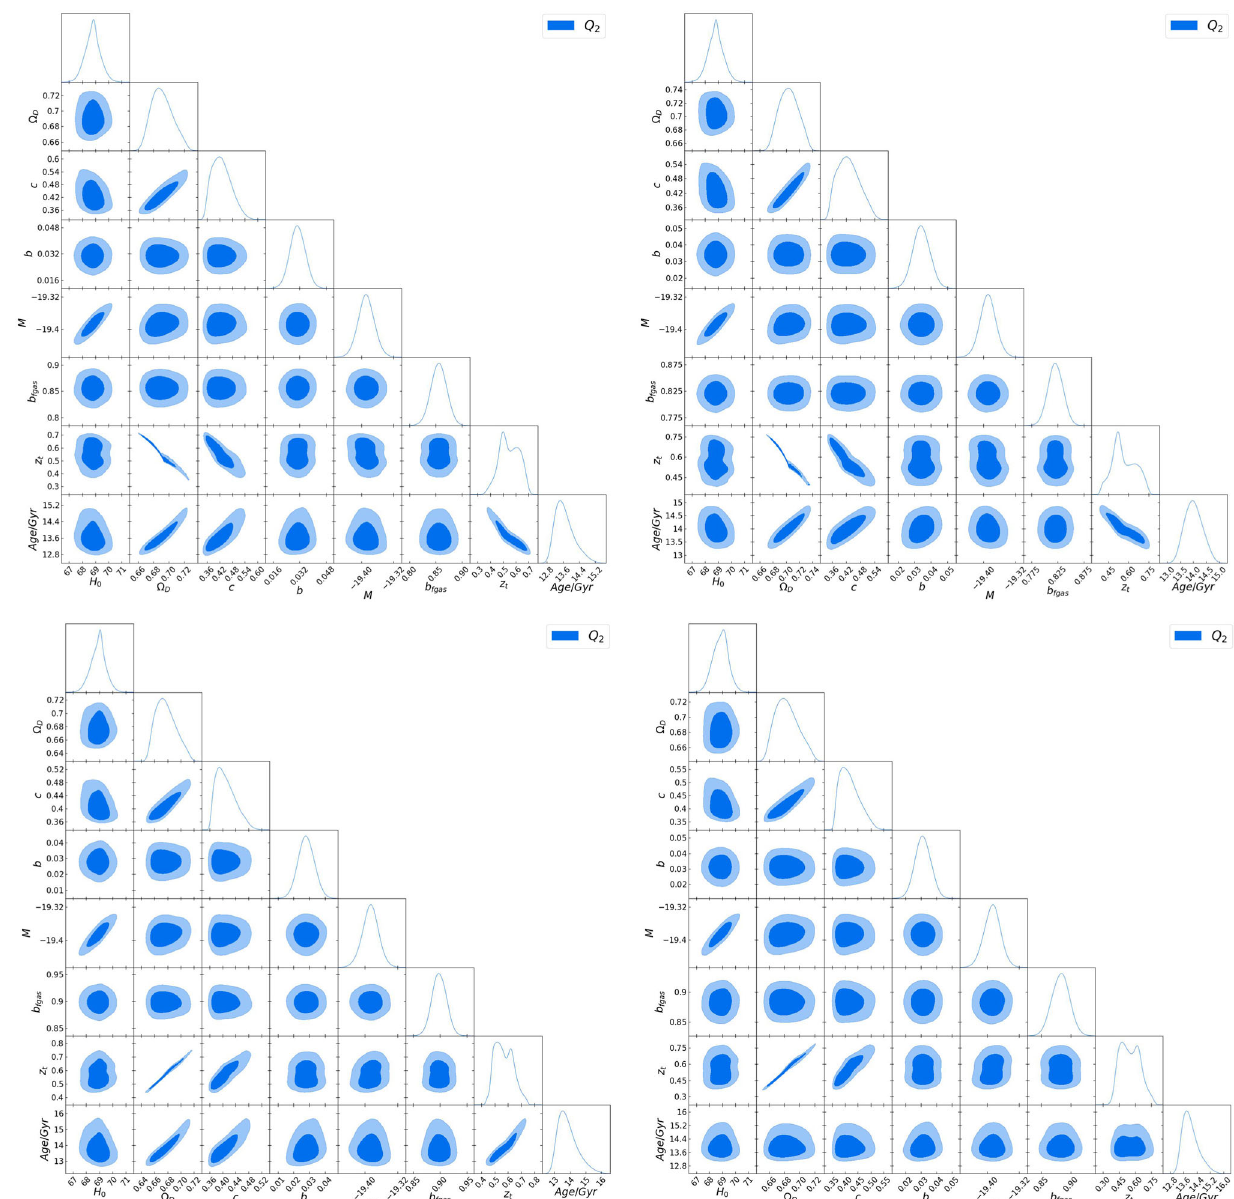
Fig. 8 The contour maps of the HRDE (see Eqs. (15) and (16)) with four types of non-linear interaction Q 4 , Q 5 , Q 6 and Q 7 listedin Table1. In this figure H 0 is the Hubble parameter, (cid:5) D is the dark energy density, α = c 2 is the dimensionless parameter, b is the coupling constant, M